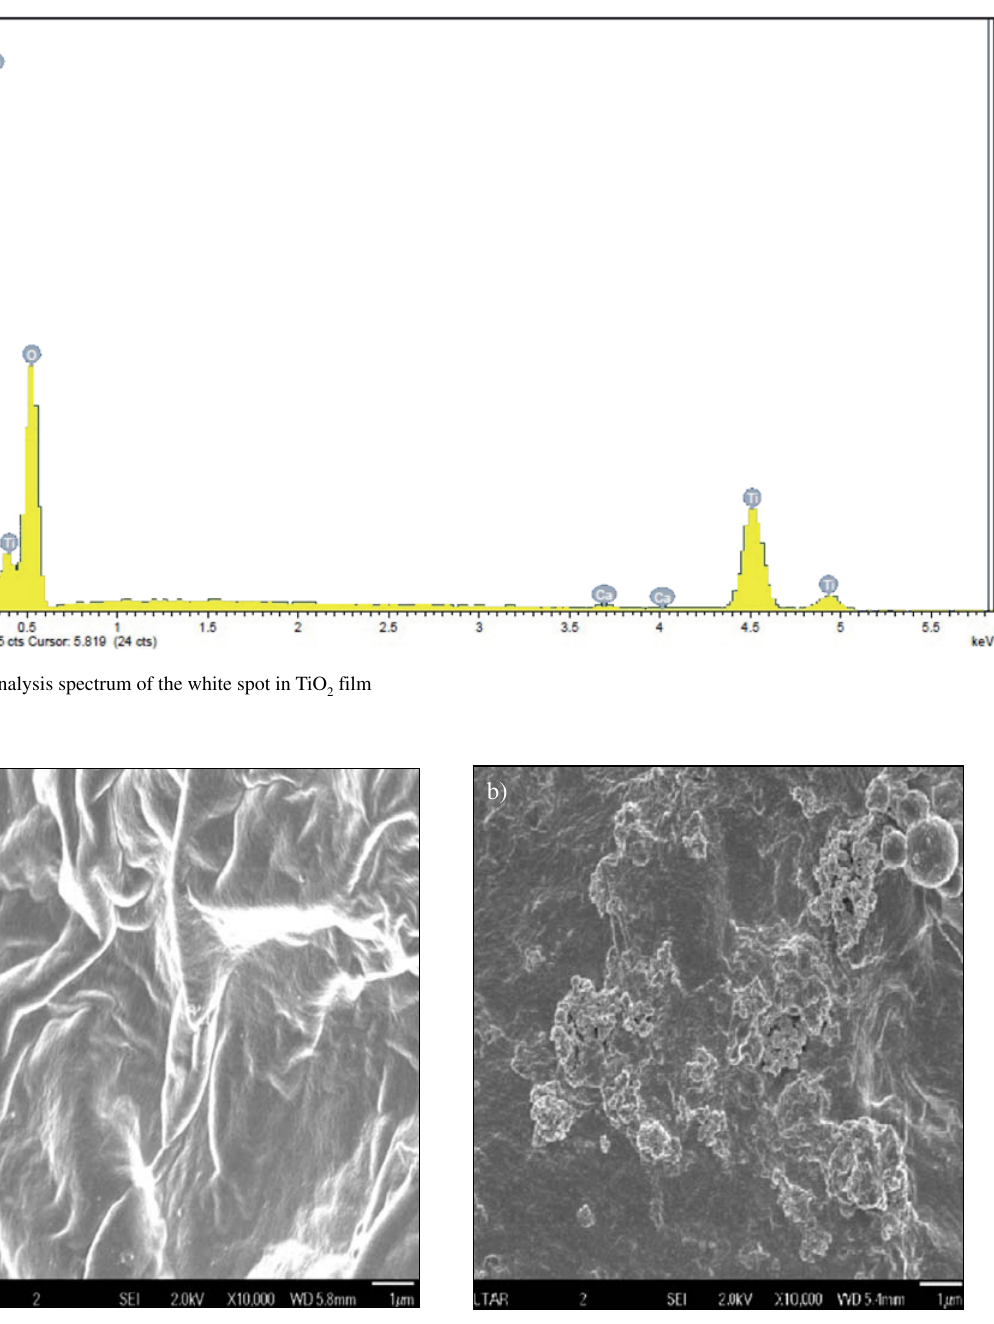
Figure 4. SEM micrographs of corn cob film before (a) and after (b) dyes removal process